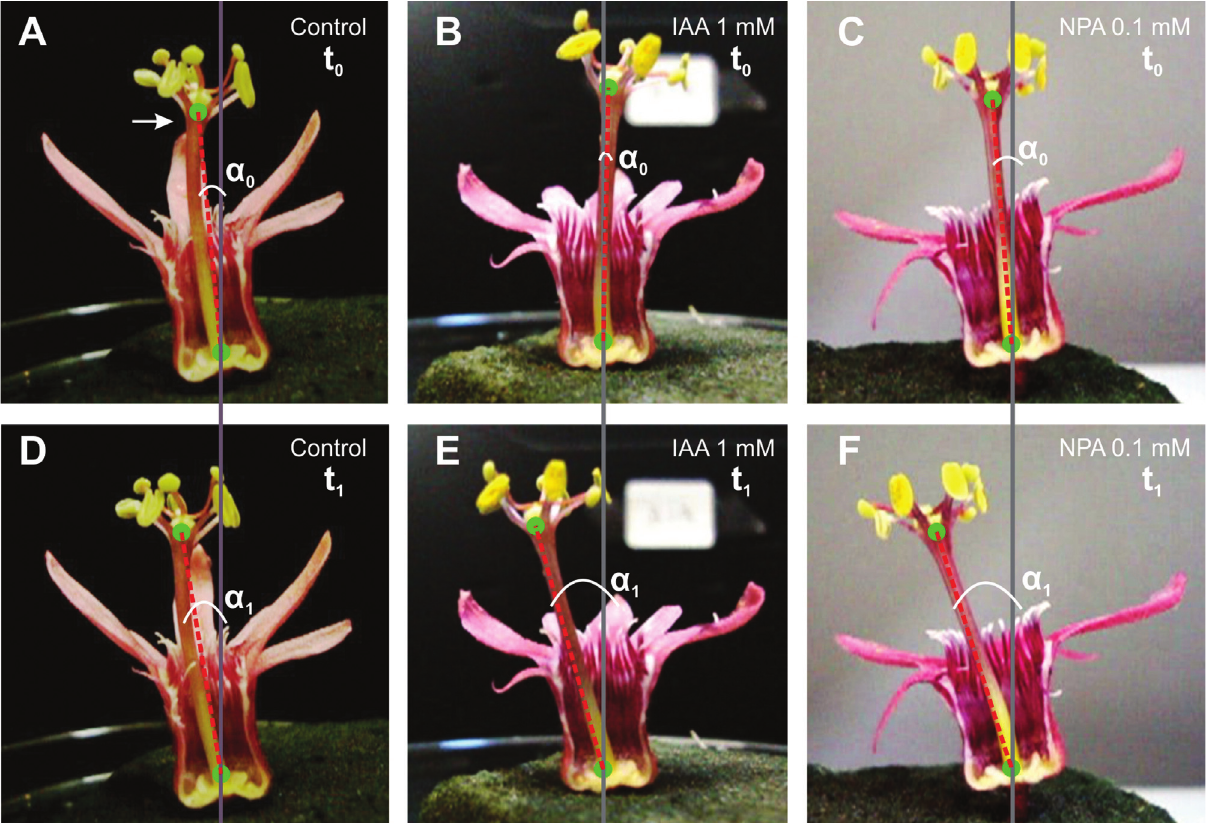
Figure 1 - Images of flowers of P. sanguinolenta showing the androgynophore before (A, B, C) and after (D, E, and F) mechano-stimulation, after being treatedwithwater(control,AandD),IAA1mM(BandE)andNPA0.1mM(CandF).Theimagesoftheandrogynophorebeforeandafterthemovement wereputexactlyinthesamepositionrelatedtotheX-axistoclearlyillustratethechangeinposition.Themovementamplitudecanbemeasuredby (cid:3) 1 - (cid:3) 0 , where (cid:3) 0 is the angle formed by the androgynophore axis before the movement (t 0 ) and a line traced perpendicularly to the image; and (cid:3) 1 is the angle formedbetweentheandrogynophoreaxisafterthemovement(t 1 )andthesameperpendicularline.NotethatwhenIAAorNPAisappliedtheamplitudeof the movement is clearly greater than in the